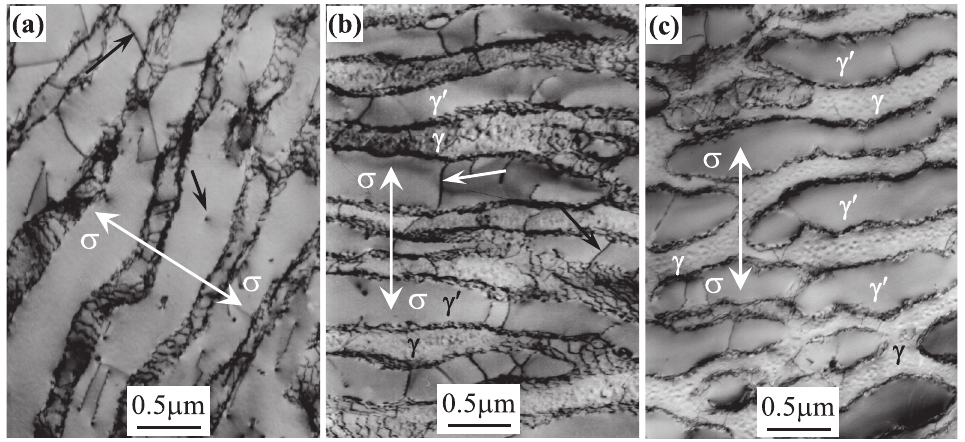
Fig. 6: Microstructure of the alloy crept up to fracture under the applied stress of 137 MPa at different temperatures. (a) At 1020 °C, (b) at 1040 °C (b) at 1060